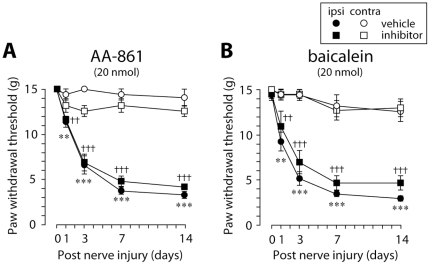
LOX inhibitors do not prevent the development of tactile allodynia after nerve injury.A, B. The 5-LOX inhibitor AA-861 (20 nmol/10 µl) (A) and the 12- and 15-LOX inhibitor baicalein (20 nmol/10 µl) (B) administered through a catheter whose tip was positioned near the L5 DRG once daily for 14 days did not suppressed the development of nerve injury-induced tactile allodynia. **p<0.01, ***p<0.001 compared with the threshold of the vehicle-treated group on day 0. ††p<0.01, †††p<0.001 compared with the threshold of the inhibitor-treated group on day 0. All data are presented as mean ± SEM of the paw withdrawal threshold of five animals.